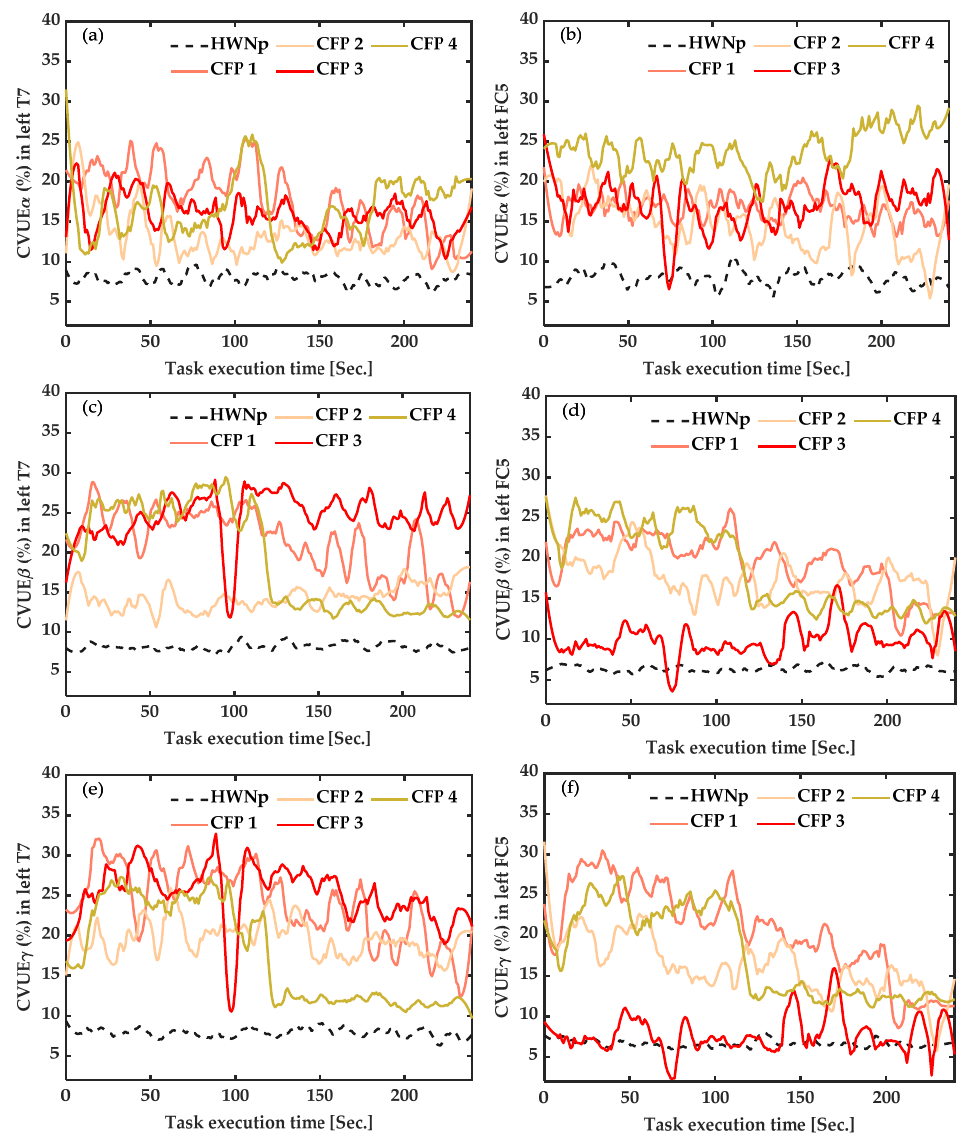
Figure 5. Active measures of the coefficient of variation of upper envelope (CVUE) in alpha (CVUE α ), beta (CVUE β ) and gamma (CVUE γ ), during task execution. ( a )—CVUE α from left temporal (T7) data, ( b )—CVUE α from left fronto-central (FC5) data, ( c )—CVUE β from left temporal (T7) data, ( d )—CVUE β from left fronto-central (FC5) data, ( e )—CVUE γ from left temporal (T7) data, ( f )—CVUE γ from left fronto-central (FC5) data. The black dotted line indicates the average of CVUE of the healthy with “No pain” (HWNp). The colored lines represent CVUE of the four par- ticipants with chronic fibromyalgia pain (CFP 1-4 ). The graphs were smoothed by a 15th-order of Savitzky–Golay filter. CVUE β and CVUE γ from T7 data were significantly increased in all